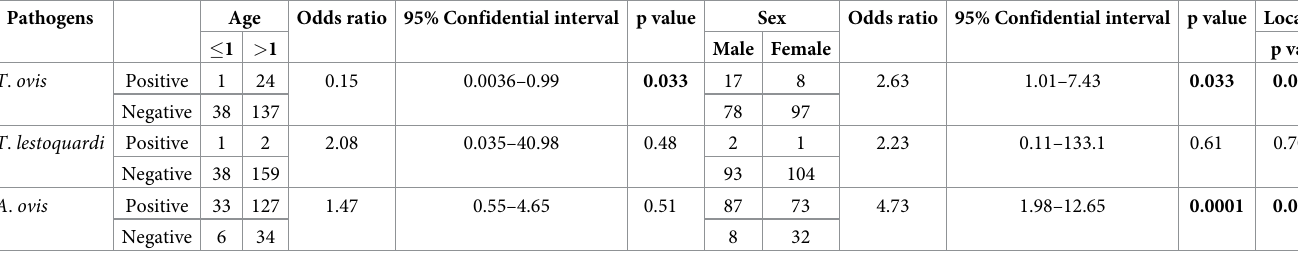
Table 3. Factors associating with the infection evaluated by Fisher’s exact